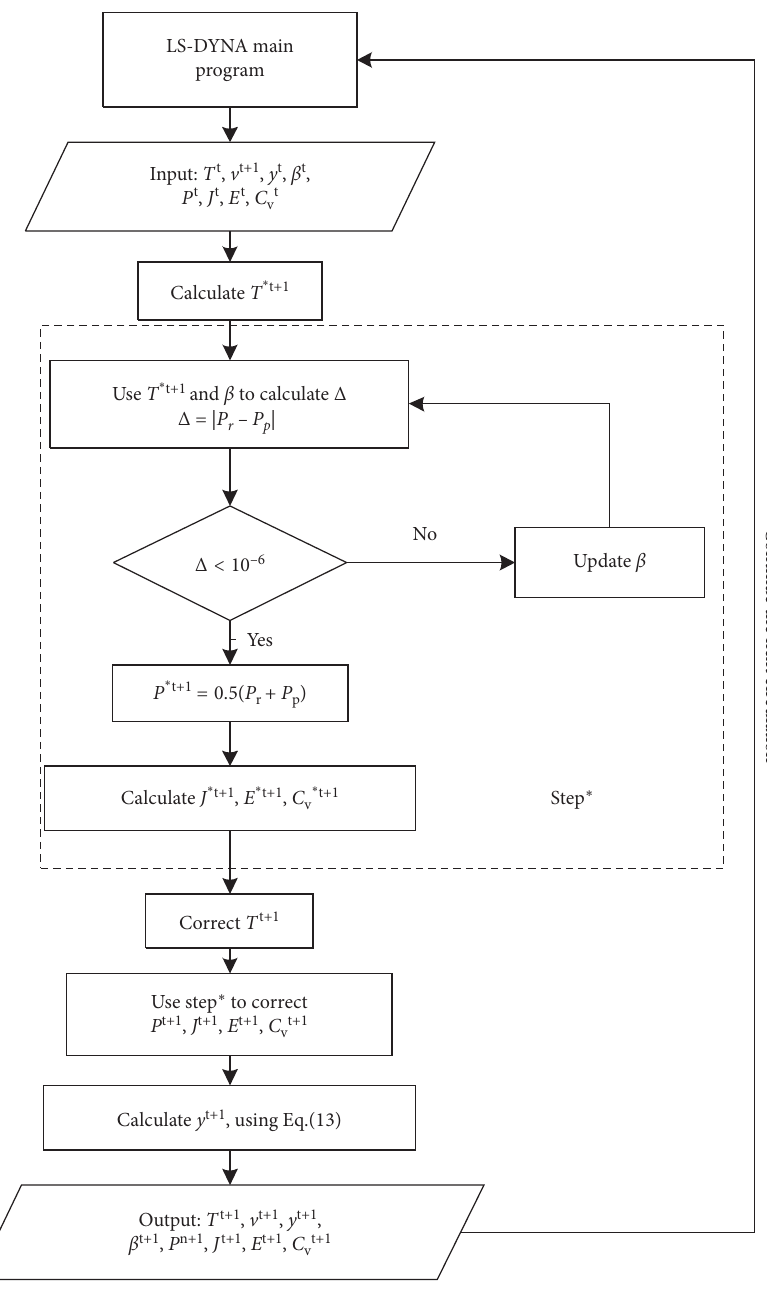
Figure 1: Program flow of user-defined